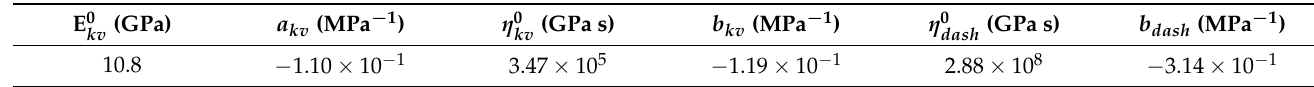
Table 1. Identified set of parameters of the proposed nonlinear creep model, for the bulk epoxy adhesive, subjected to sustained tensile loading.